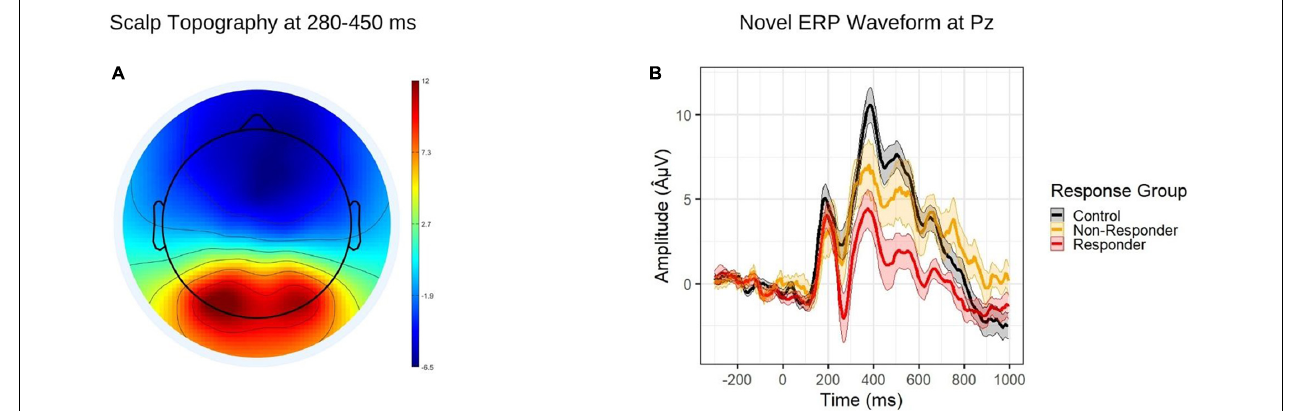
FIGURE 1 | (A) Topographic map depicting grand average amplitudes to novel stimuli during the P3a time window (280-450 ms). (B) ERP waveform to novel stimuli at the Pz electrode, by response group. The shaded regions depict standard errors of the mean.